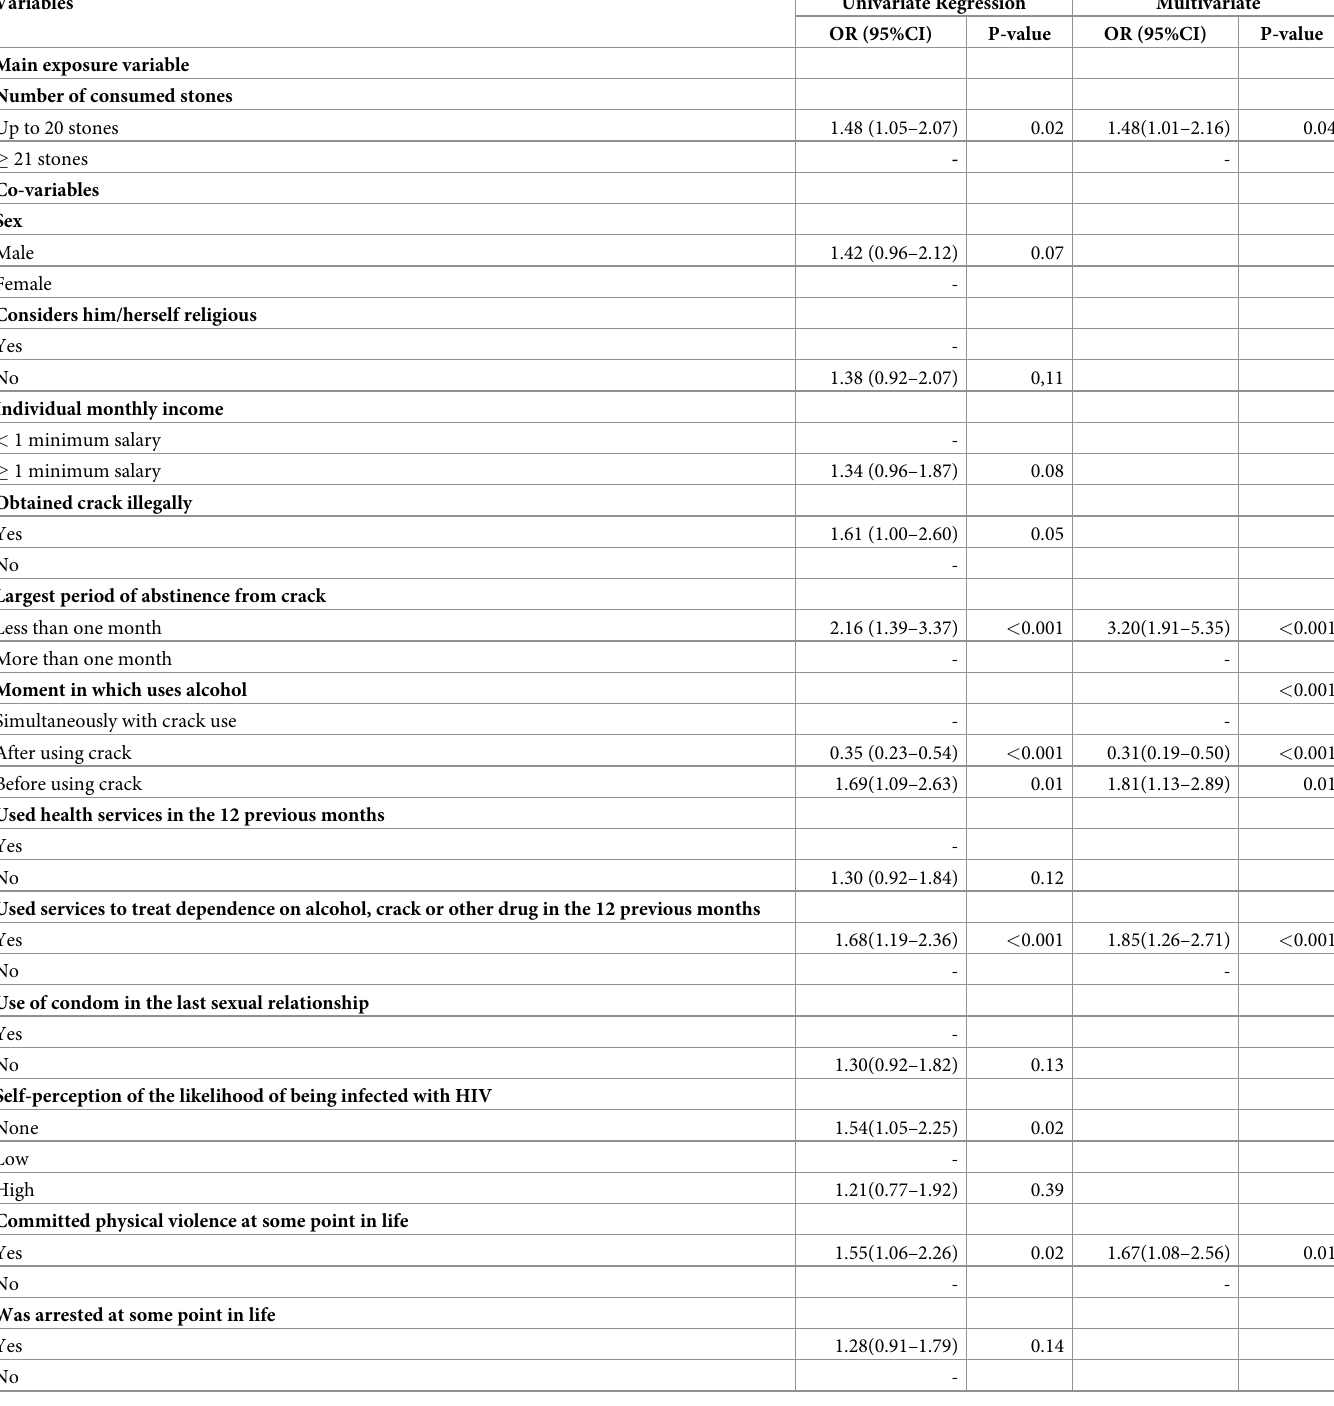
Table 4. Odds Ratio and confidence interval for alcohol use with the effect of potentiating crack craving among people who use crack assisted in the Atitude Pro- gram, Pernambuco, August 2014 to August 2015, according to the multivariate regression